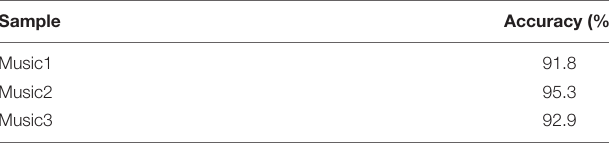
TABLE 1 | Accuracy of the stacked autoencoder.